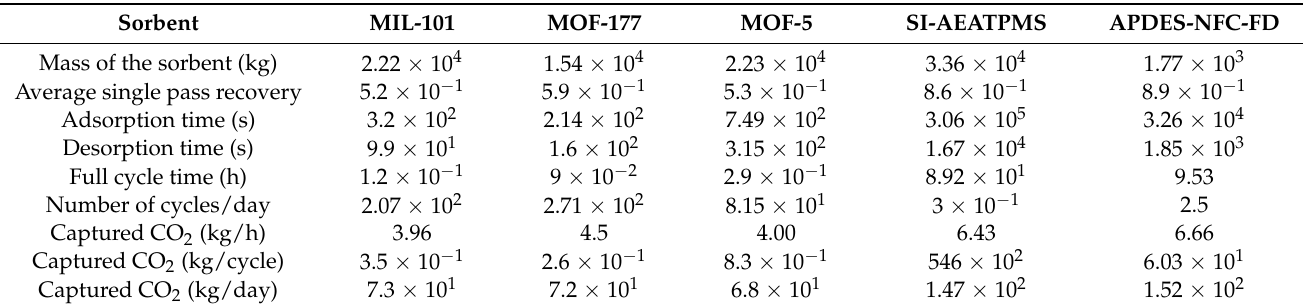
Table 10. Main results from adsorption and desorption